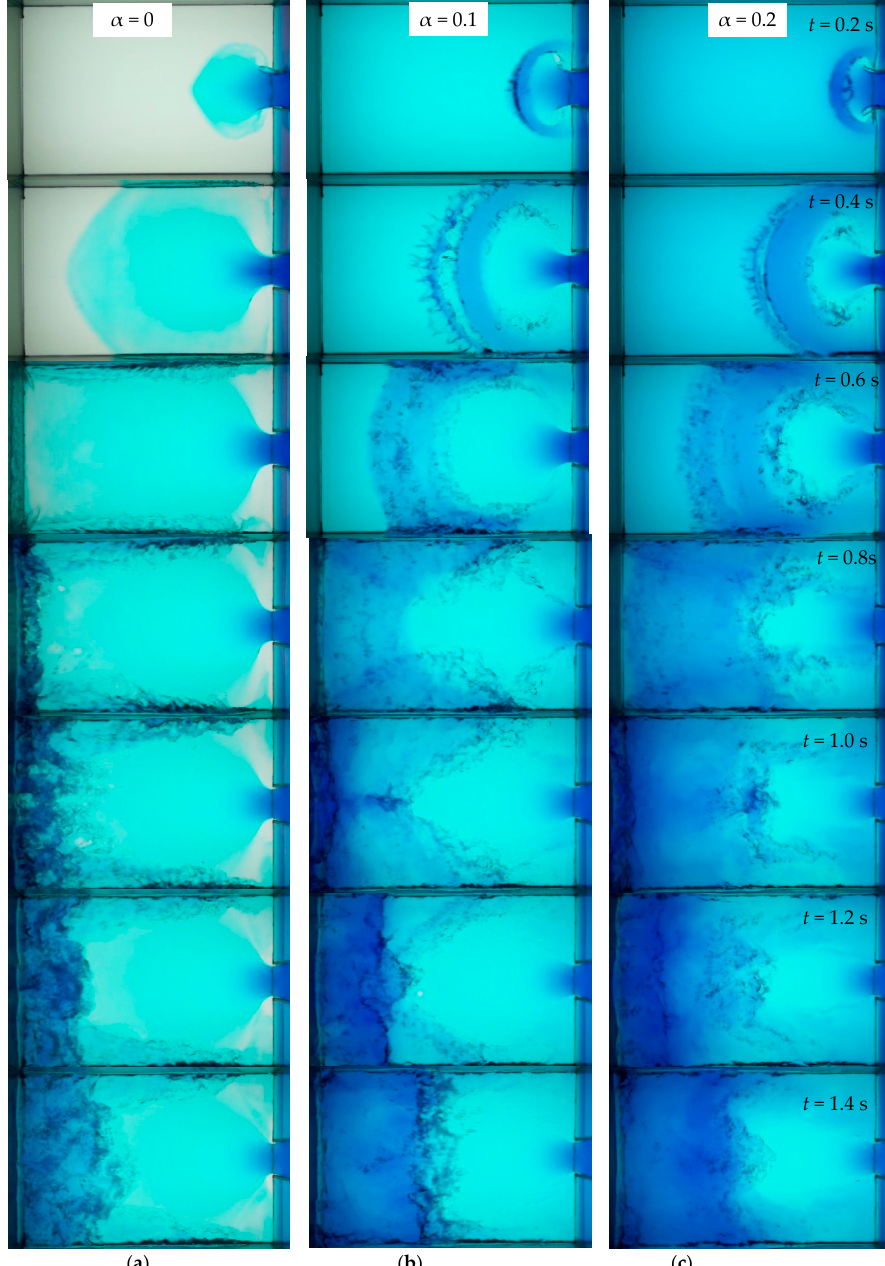
Figure 4. Comparison of tailwater depth effect on wave propagation for tests ( a ) D1, ( b ) W1, and ( c ) W2.